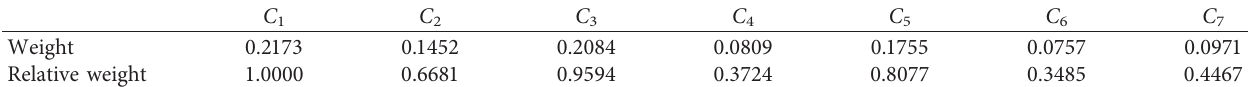
Table 3: The relative weight.